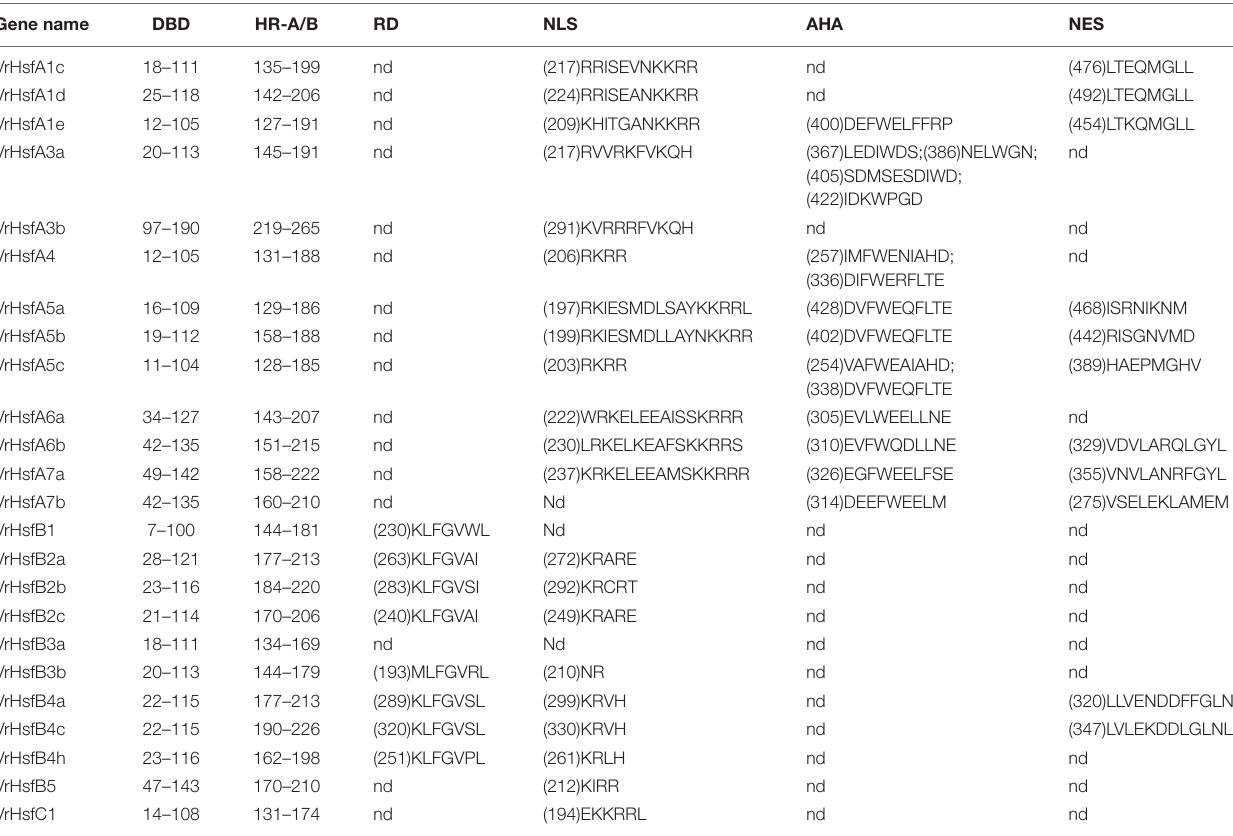
TABLE 2 | Functional domains of mungbean VrHsf